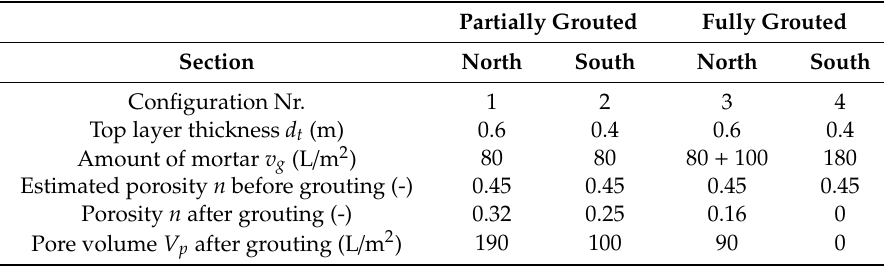
Table 2. Characteristics of the MGRRs in the